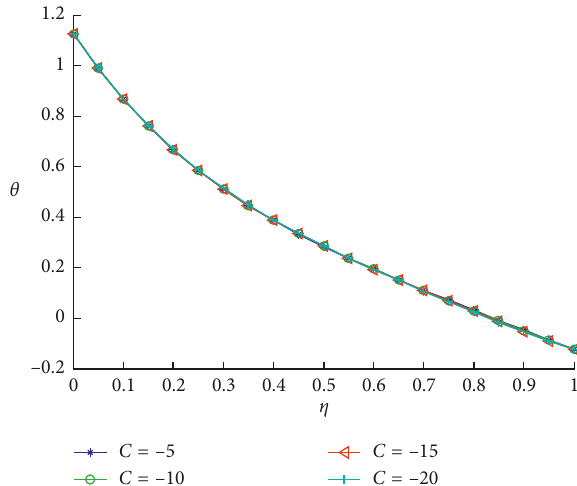
Figure 12: Effect of the pressure gradient on the temperature profile when A Pr 1 . 0 , and c (cid:31)